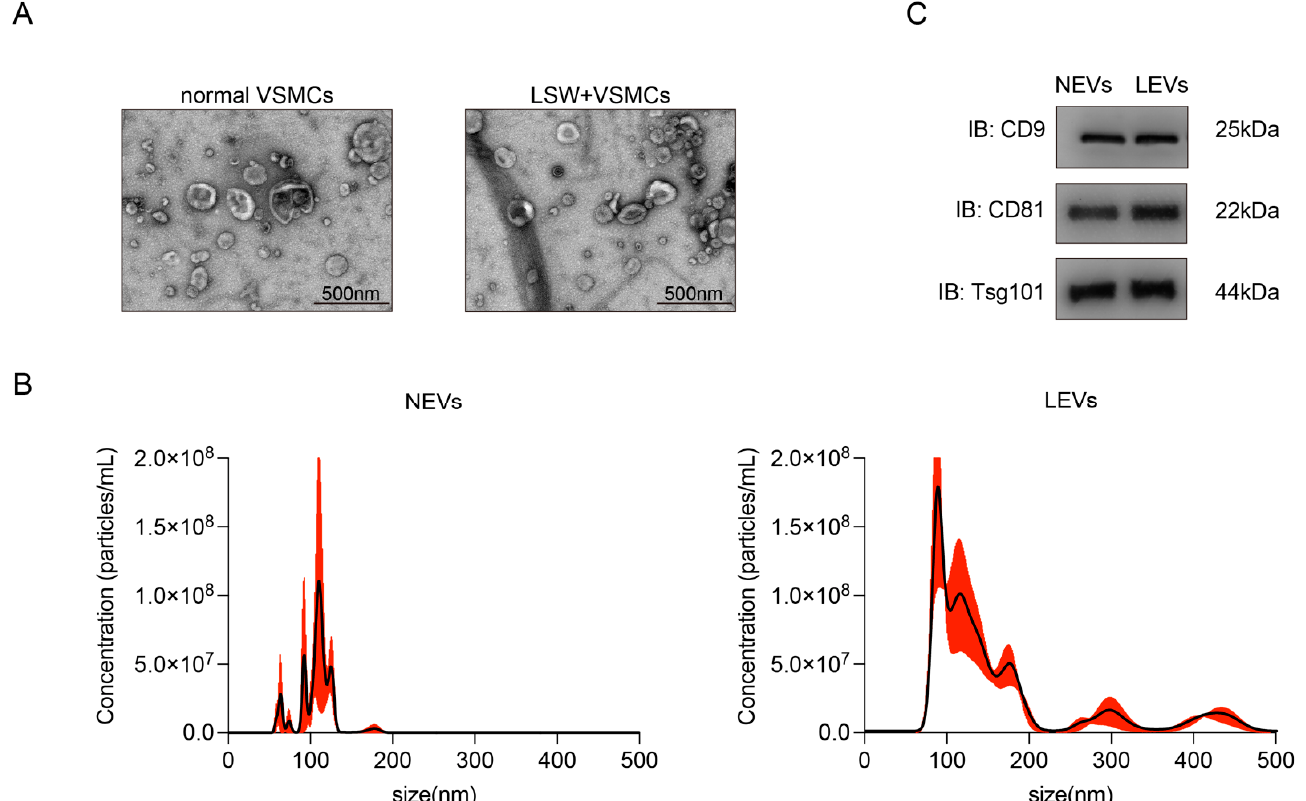
Figure 2. Characterization of extracellular vesicles produced from VSMCs with or without LSW treatment. ( A ) TEM analysis of EVs from normal VSMCs without LSW treatment (NEVs, left panel) and LSW-treated VSMCs (LEVs, right panel). Scale bar, 500 nm. ( B ) Particle sizes of NEVs and LEVs, as measured with the NanoSight analysis. ( C ) The expression of EV-specific markers CD9, CD81, and Tsg101 was measured with western blot analysis.